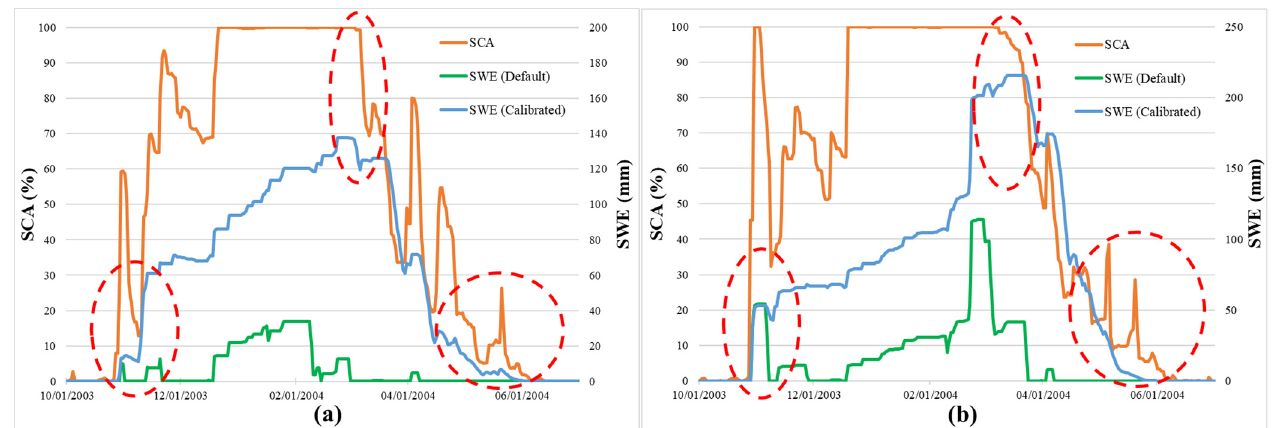
Figure 3. Critical parts of SWE–SCA comparison chart in an example year for ( a ) Murat and ( b ) Karasu basin.